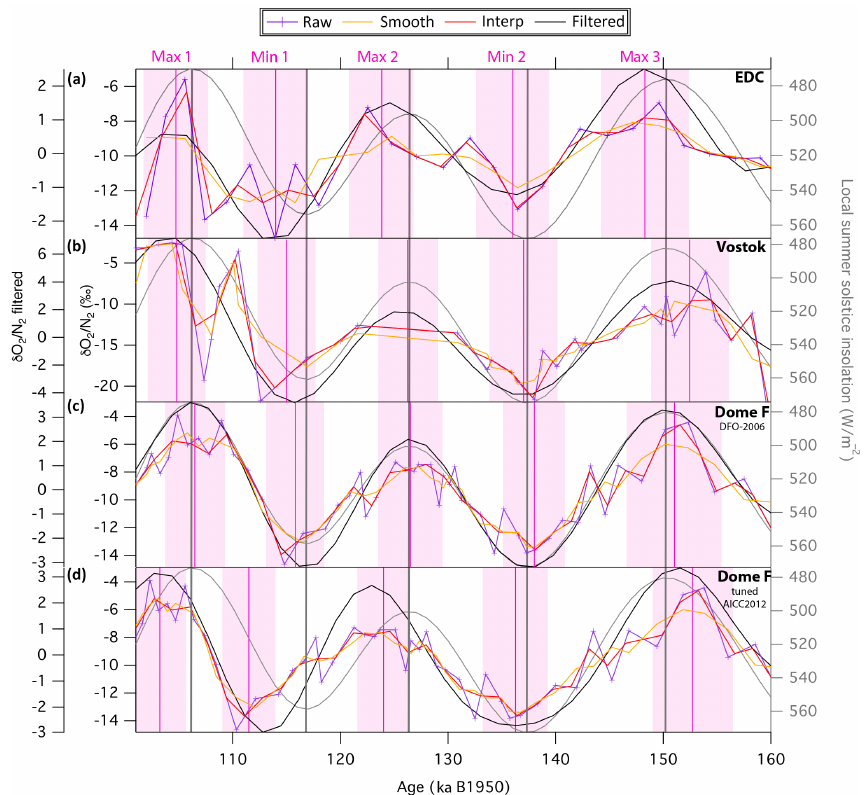
Figure C1. Determination of the uncertainty associated with δ O 2 / N 2 orbital tuning using different treatment of data for EDC (a) , Vostok (b) Dome F on DFO-2006 (c) and Dome F tuned on AICC2012 (d) over MIS 5. The raw δ O 2 / N 2 records are presented in purple, the smoothed ones (3-points running average) are in orange, the reinterpolated curves are presented in red and the filtered records are in black. The local summer solstice insolation are represented in grey for each site. The pink vertical bars represent the mean age of minima and maxima identified, with their calculated uncertainty illustrated by the pink shaded zones. The identification of extrema indicated on top of the figure corresponds to the same ID as in Table C1. The grey vertical bars show the timing of minima and maxima in the insolation